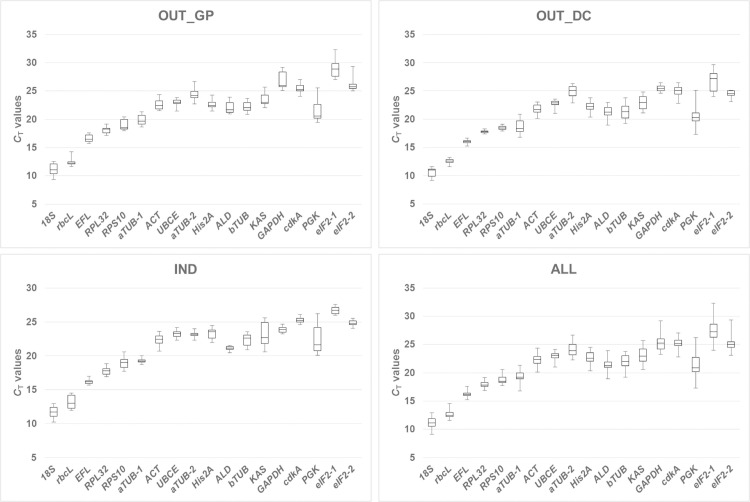
CT values of candidate reference genes in all tested microalgae samples and conditions.The thick central line in boxes represents the median value, whereas the lower outline and the upper outline in boxes show the quartile 1 (Q1) and 3 (Q3), respectively. Whiskers are set at 1.5 times the interquartile range (IQR) both above Q3 and below Q1.